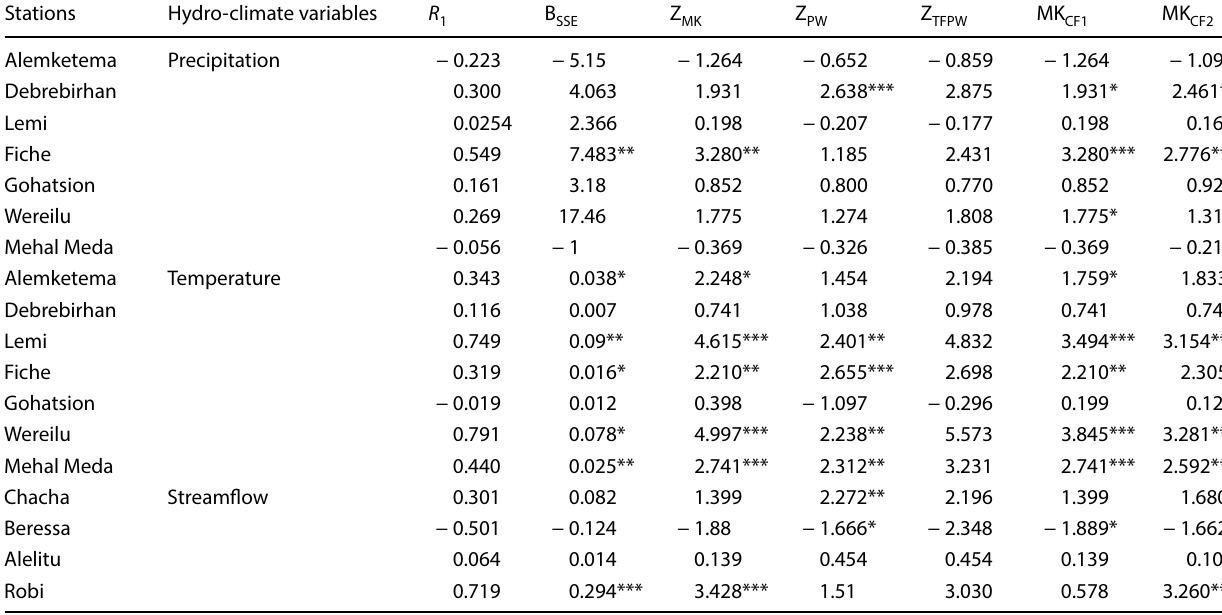
Table 3 The annual trends of hydro-climatic variables Stations